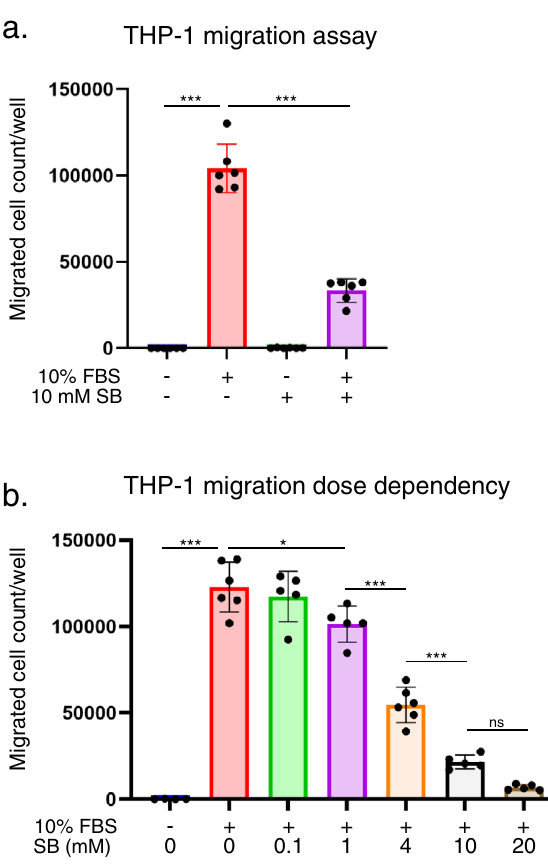
Figure 6. Transwell assay shows that SB reduces THP-1 migration. ( a ) The total number of cells in each well in the lower chamber of the 5 μm-pore transwell were counted and plotted after 24 h of incubation (n = 6 each). Cell counts per well were significantly lower in the FBS + SB group compared with the FBS group. ( b ) SB dose dependency was confirmed by applying different concentrations of SB to the upper chamber of the transwell (n = 4–6). Higher SB concentrations significantly reduced the number of migrating cells. * p < 0.05; *** p < 0.001; ns, not significant. Each bar represents mean ± SEM. FBS, fetal bovine serum; SB, sodium